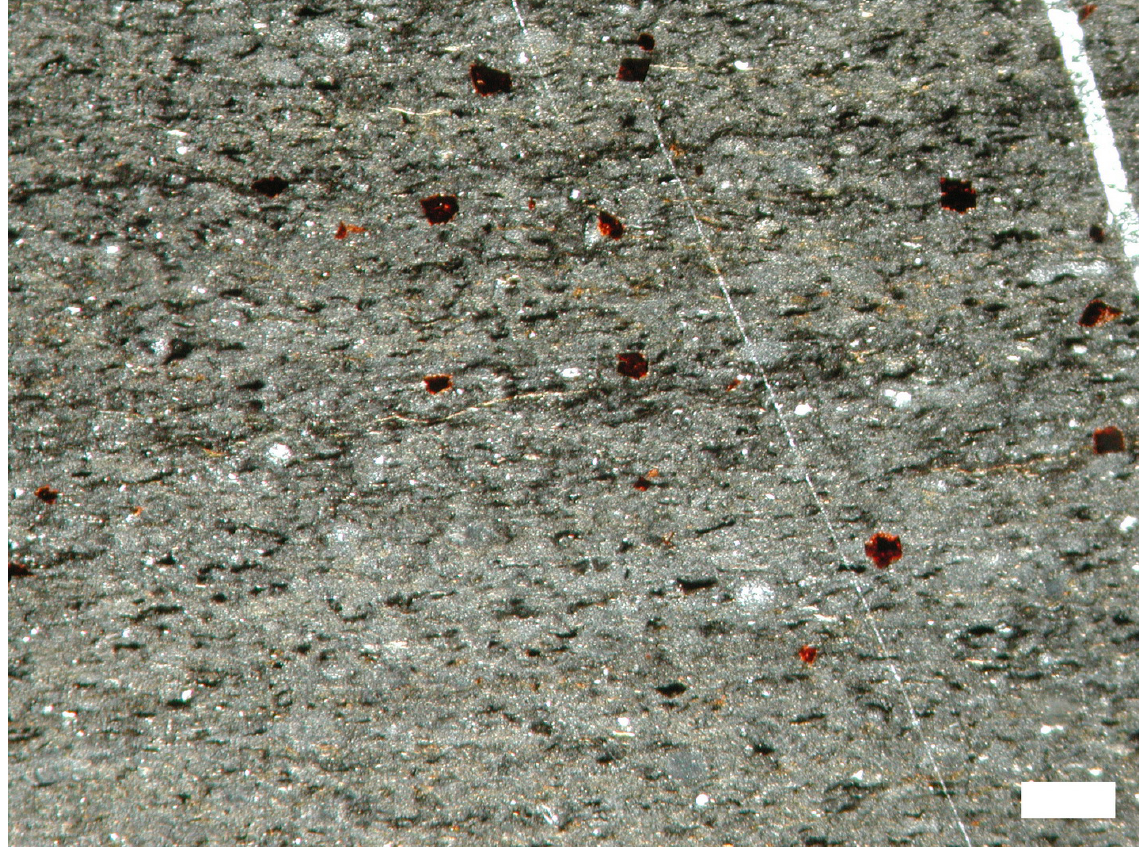
Figure 9: Detail of the matrix of sample 298 from El Espertín at 40x (xpl). Organic matter accumulations and some pyrites can be noted. (Scale bar = 250µm) (Source: Fuertes et al .